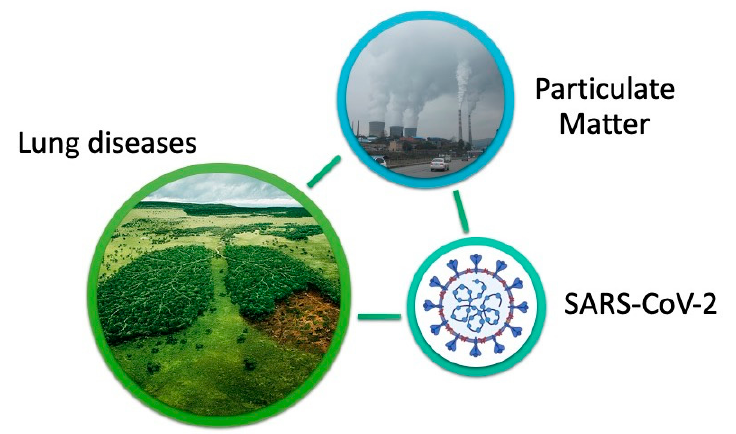
Figure 6. Particulate matter may act as a virus-carrier, and might therefore have contributed to the spread of the novel coronavirus in highly polluted environments such as the Po Valley in Italy and Wuhan in China. Modified from CC BY-NC 2.0, image created by Daniel Lovquist, kindly acknowledged.